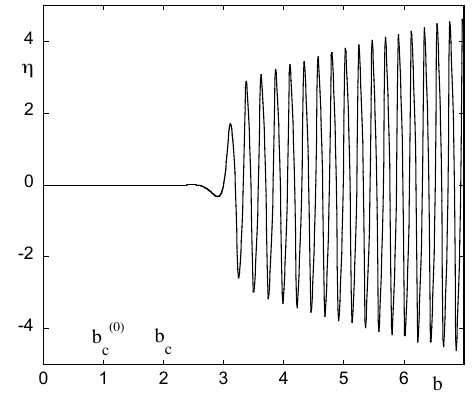
Figure 1. Evolution of variable η versus the instantaneous value of the feedback parameter b as obtained numerically from model (8) in the presence of a time dependence b = b 0 + (cid:15)t with b 0 = 0, a = 4 and (cid:15) = 0 . 01.